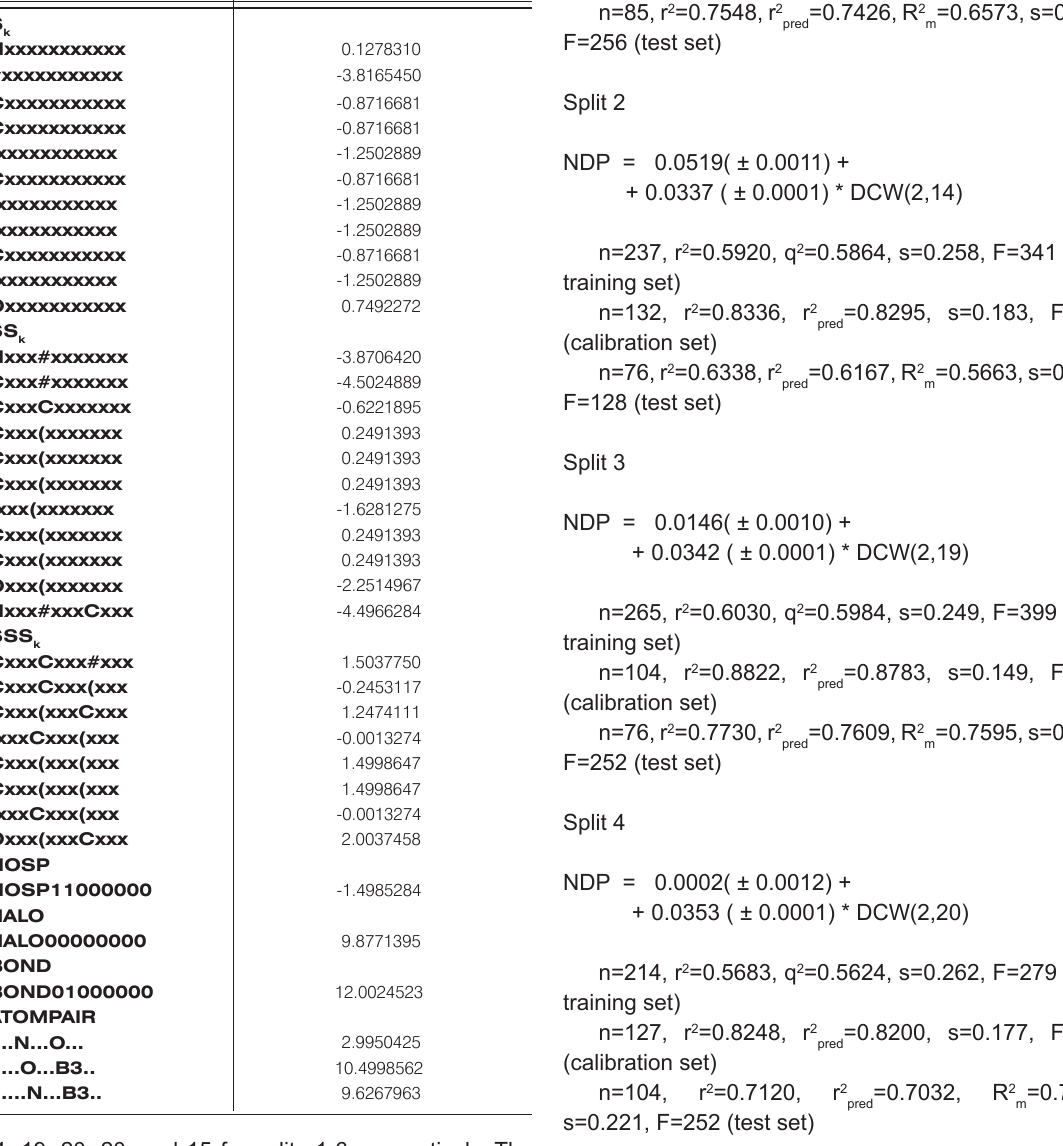
SMILES attribute (SA) Correlation